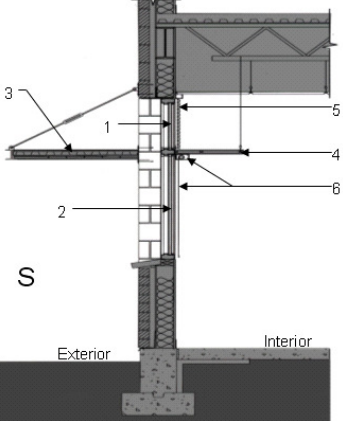
Fig. 5. The concept of a daylight window 2. Viewing Window: solar factor of 0.7 or lower. For